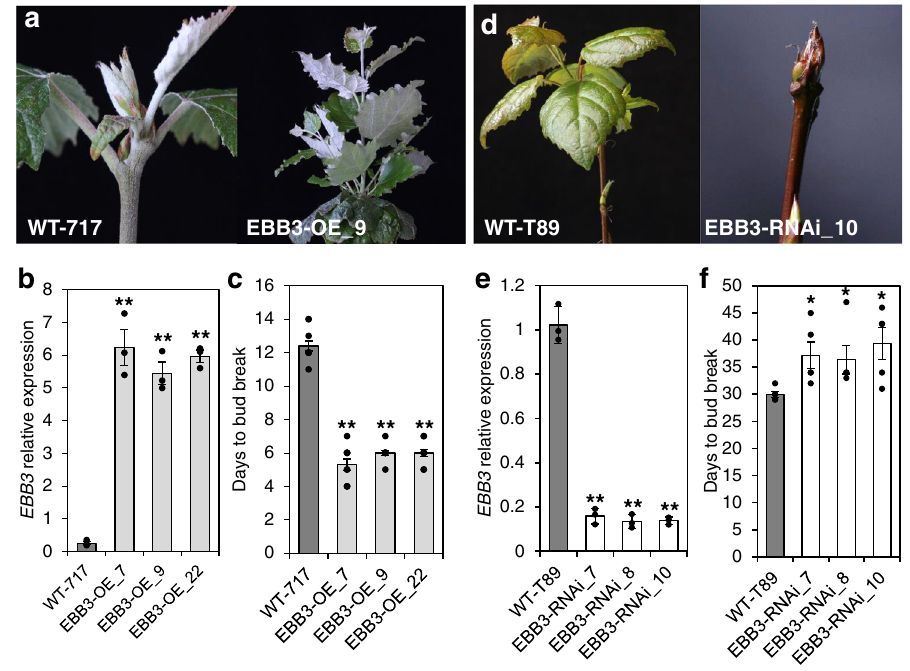
Fig. 2 EBB3 over- and under-expressing lines show early and late bud-break phenotypes respectively. a Early bud-break of a representative over- expressing line compared to WT-717 control plant. b EBB3 relative expression in EBB3-OE lines. c Time to bud-break in WT-717 plants and EBB3-OE lines. d Delayed bud-break in representative EBB3 under-expressing line compared to WT-T89 control plant. e EBB3 relative expression in EBB3-RNAi lines. f Time to bud-break relative to WT-T89 control plants in EBB3-RNAi lines. Expression values are average of three biological replicates ±SEM, normalized to the reference ACT7 for WT-717 and UBQ gene for WT-T89 clones, respectively. Asterisks (*) indicate signi fi cant and (**) indicate extremely signi fi cant differences compared to WT at P < 0.05 and P < 0.0001, respectively, and determined by two-tailed paired t -tests. Source data underlying Fig. 2a, c, and d are provided as a Source Data fi